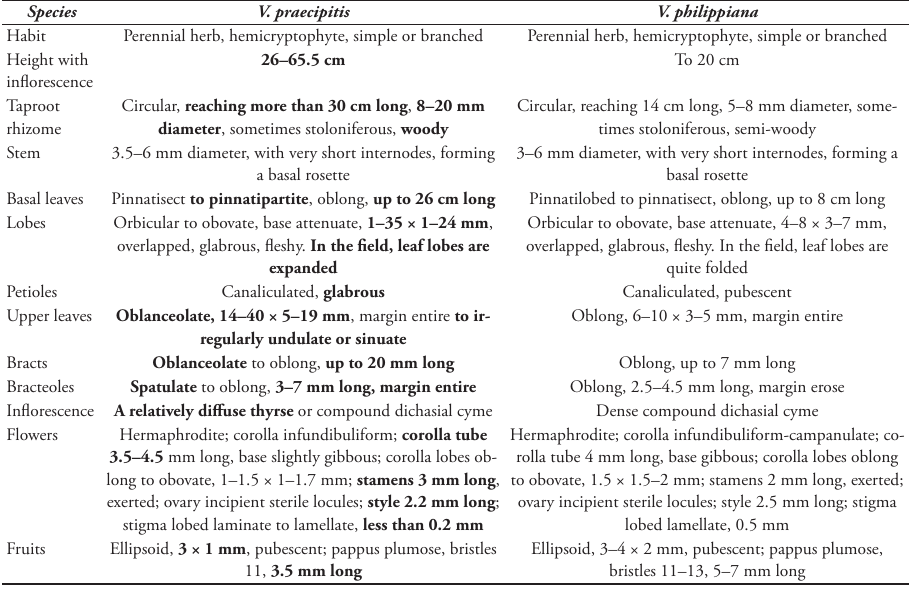
Table 1. Morphological differences between Valeriana praecipitis and V. philippiana . Based on Borsini (1966) and Kutschker (2008, 2011). In bold: character unique to V. praecipitis